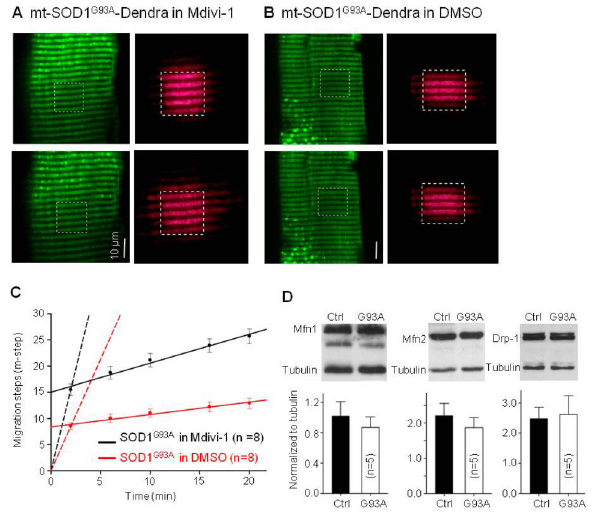
Figure 6. A-C. The effect of Mdivi-1 on migration of mt- SOD1 G93A -Dendra expressed in normal muscle fibers . ( A ) Migration in the presence of Mdivi-1; ( B ). Migration in DMSO as a control. ( C ) The migration time course of mt- SOD1 G93A -Dendra. Solid lines are the linear regression of the data after 2 minutes of the photoactivation. Dashed lines are the linear regression of the data in the first 2 minutes. The migration rates are listed in Table 1 . (P<0.01). Note, Mdivi-1 closely restored the migration rate of mutant mt-SOD1 G93A - Dendra. ( D ) Western blot analysis of Mfn1, Mfn2 and Drp1 in skeletal muscle of G93A and control (ctrl) mice. There are no significant changes in expression level of these mitochondrial fusion/fission proteins in G93A muscle at the age of 2 month. (n=5 mice for control and G93A